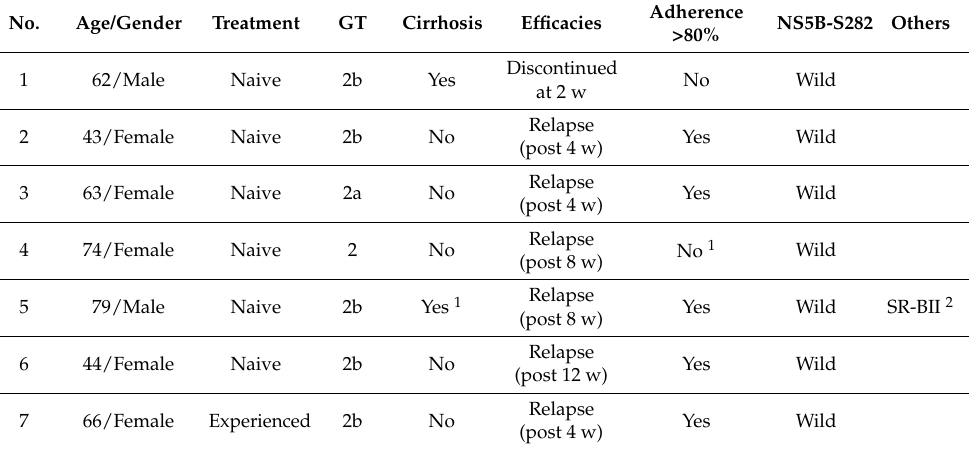
Table 4. Seven patients who failed to respond to sofosbuvir plus ribavirin treatment.